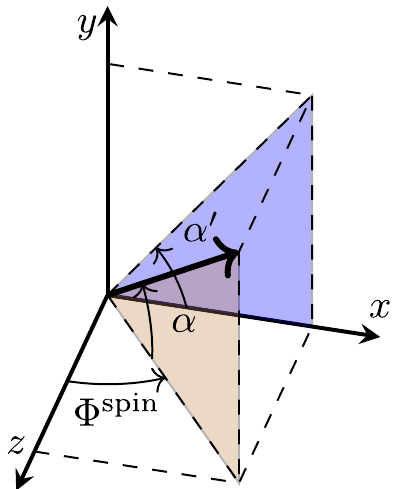
FIG. 1. Coordinate system used to describe the spin motion. The z -axis is defined by the nominal beam momentum, the y -axis points upward and the x -axis to the side. α is the angle between the polarization vector and the horizontal plane. α 0 is the angle between the projection of the polarization vector onto the xy -plane and the x -axis. ϕ spin is the phase of the spin